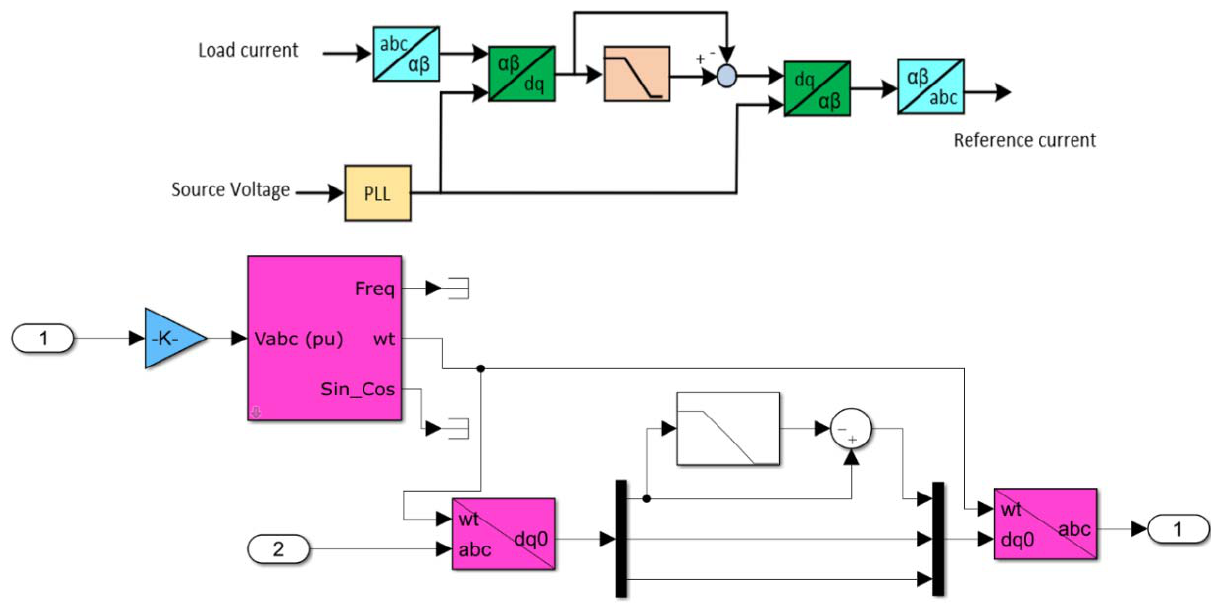
Figure 5. Shunt inverter controller